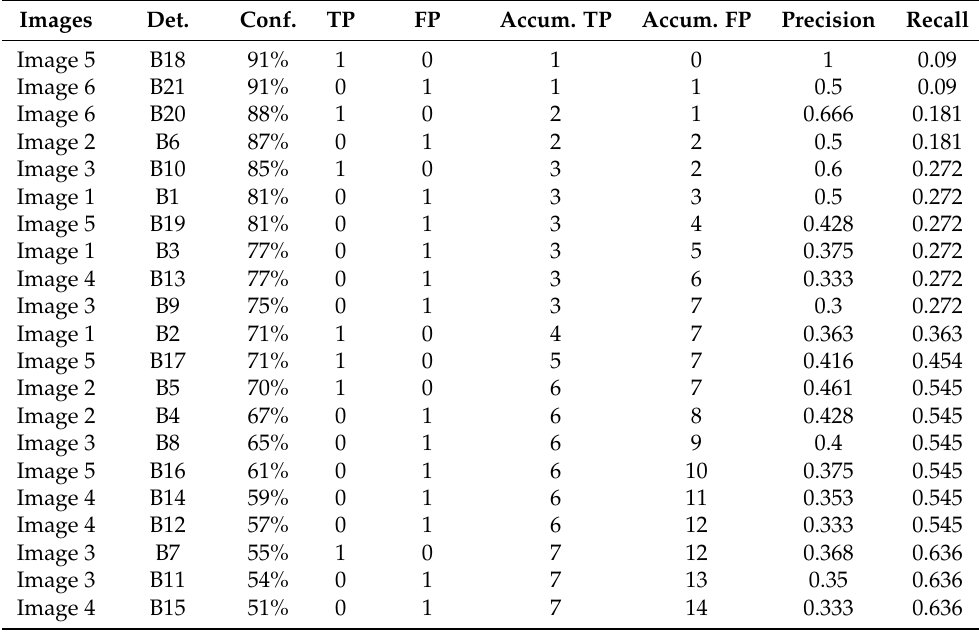
Table 4. Precision and recall for each accumulated detection bounding box ordered by the confidence measure. Det., Conf., and Acumm. denote detection, confidence, and accumulated,